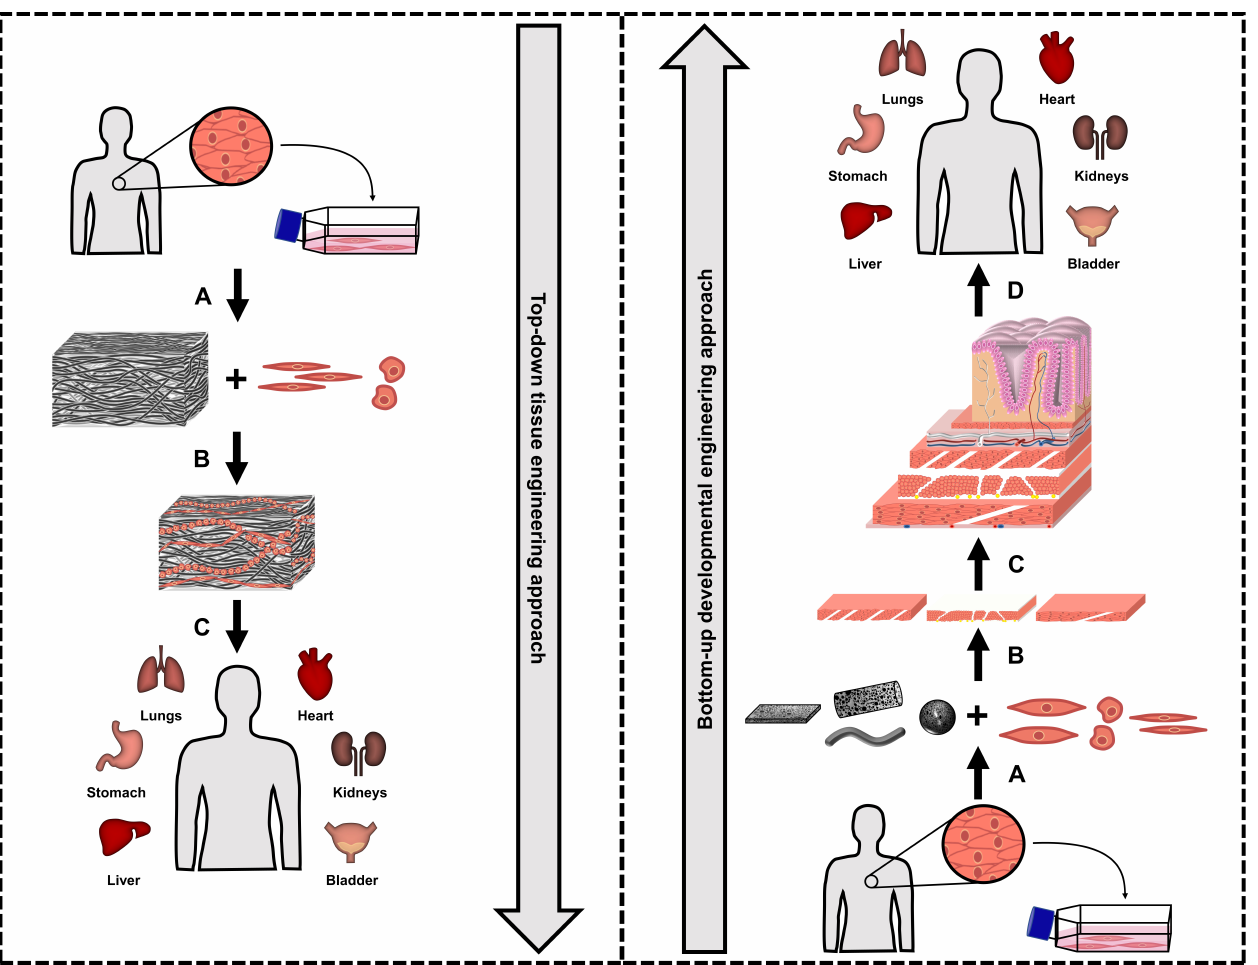
Figure 1. Comparison of the traditional top–down tissue engineering ( left ) and the bottom–up developmental engineering ( right ) approaches towards tissue reconstruction. The top–down tissue engineering approach ( left ) starts with ( A ) the isolation of the suitable dominant cell type(s) and the expansion of these isolated cells; the next step is ( B ) a one-stage process for seeding and culturing few dominant cell types of the target tissue in a three-dimensional scaffold with equivalent sizes and shapes as the target tissues/organs; ( C ) the reconstructed tissues can be used for clinical applications. The bottom–up developmental engineering approach ( right ) starts with ( A ) the isolation of multiple cell types and the expansion of these isolated cells separately; the next step is ( B ) the independent preparation of multiple modular tissue building blocks by culturing different cell types on corresponding modular scaffolds with specific sizes and morphologies; this is followed by ( C ) the gradual tissue reconstruction via layer-by-layer assembly of the modular tissue building blocks to reconstruct ( D ) the designated functional tissues/organs for clinical